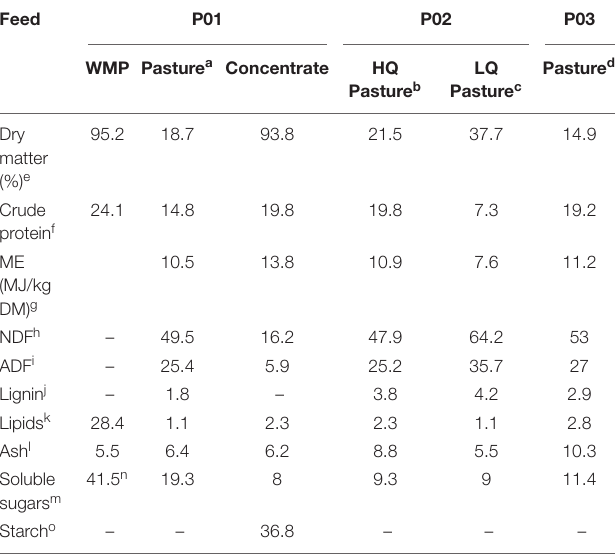
TABLE 1 | Chemical composition (% of dry matter) of the whole milk powder (WMP), concentrate and pastures a fed to calves in phase 1 (P01), pastures of high b (HQ) and low quality c (LQ) in phase 2 (P02) and pastures d fed to all calves in phase 3